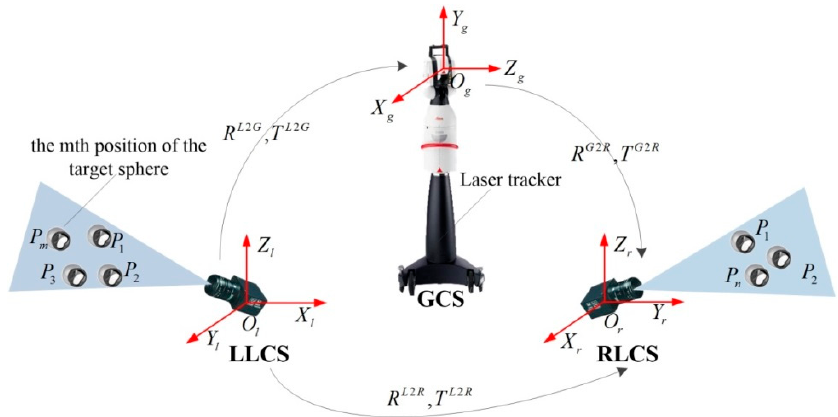
Figure 1. Illustration of the calibration procedure for two non-overlapping cameras.